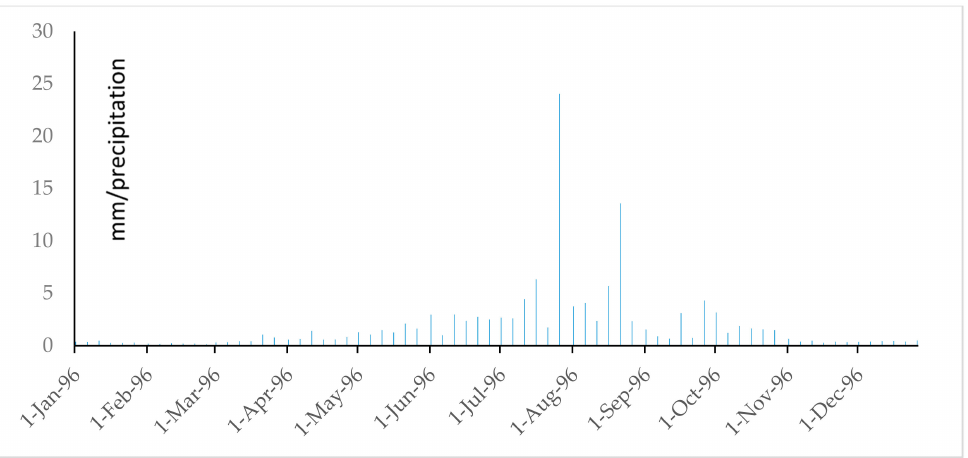
Figure A24. Precipitation of Denko County in